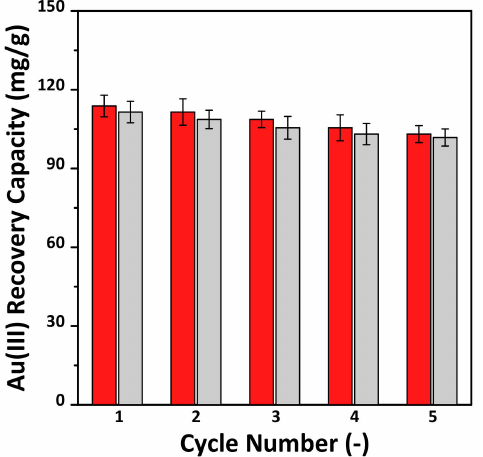
Figure 8. Cycle performance of Au(III) recovery capacity on the thiol-functional adsorbent (MS-3M- SH) prepared by using the synthesized MS-3M support: pH 2.0, V/m = 1.0 L/g, [Au(III)] = 300 mg/L and 25 ◦ C for 24 h. Desorption was conducted at 2M HNO 3 and 0.1 g thiourea solution at 25 ◦ C for 24 h. Error bars denote standard